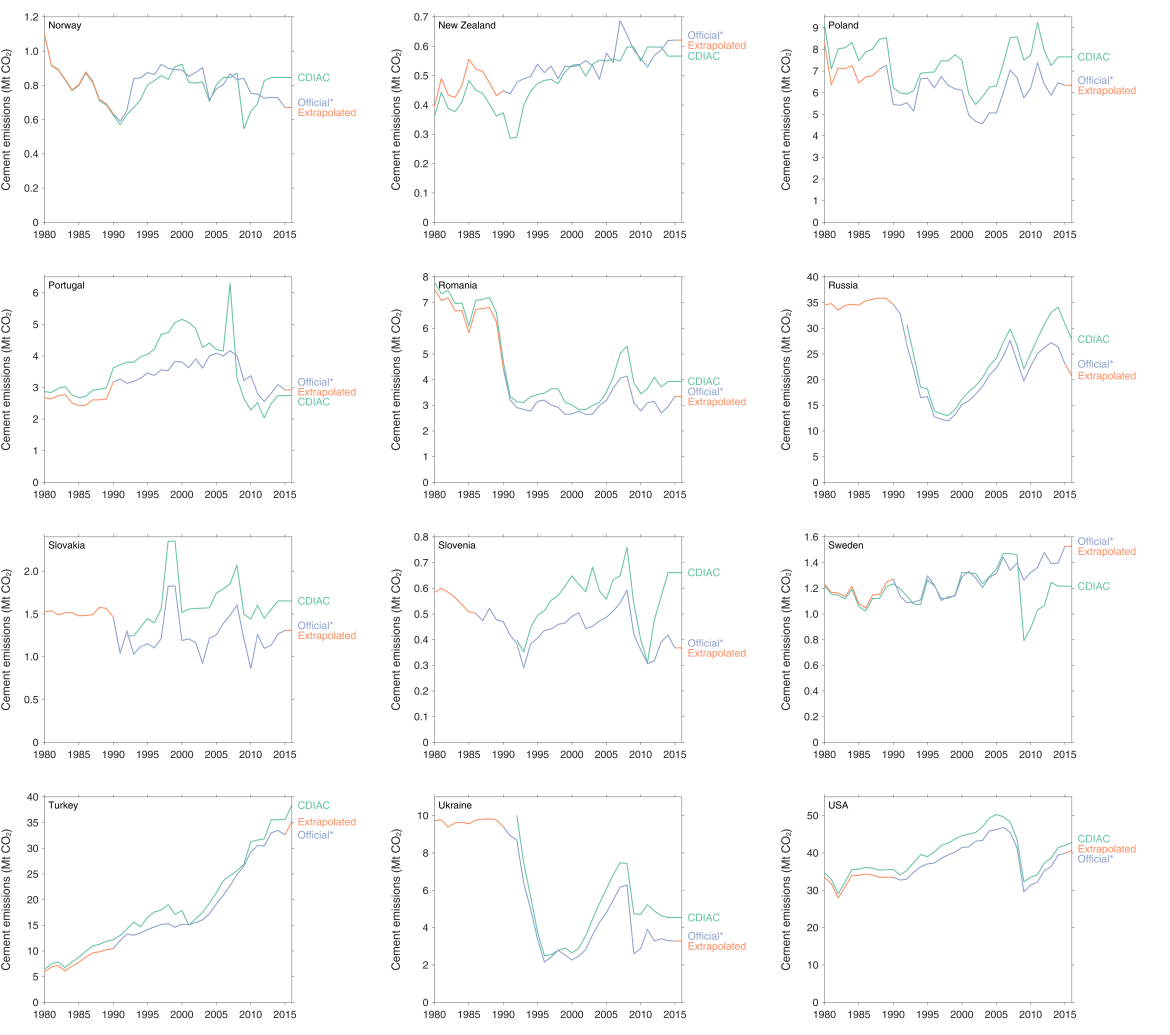
all clinker production reported by CCA in the previous edi-